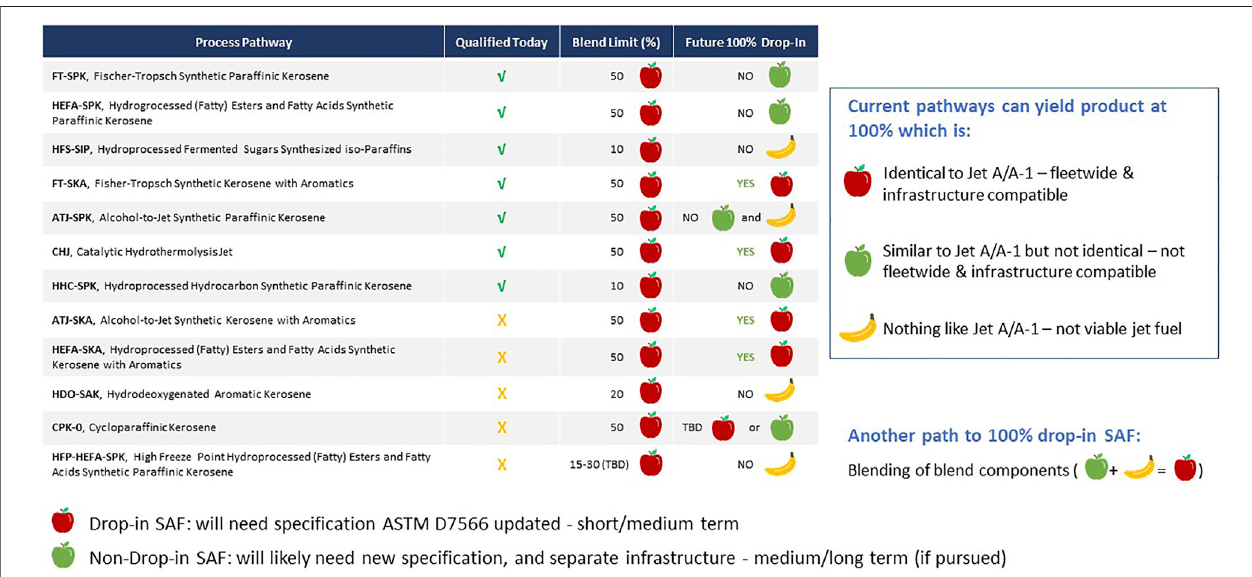
FIGURE 1 | Types of synthesized fuel blendstocks and their ability to be used as drop-in fuels as blendstocks or as stand-alone fuel. The red apples indicate fuels that can be drop-in, green apples are similar to drop-ins and may be usable in some existing aircraft but would require modi fi cation of the existing speci fi cations and possibly infrastructure, and bananas indicate fuels that are completely different from petroleum-based kerosene and could not be used as stand-alone jet fuel in current infrastructure or equipment.